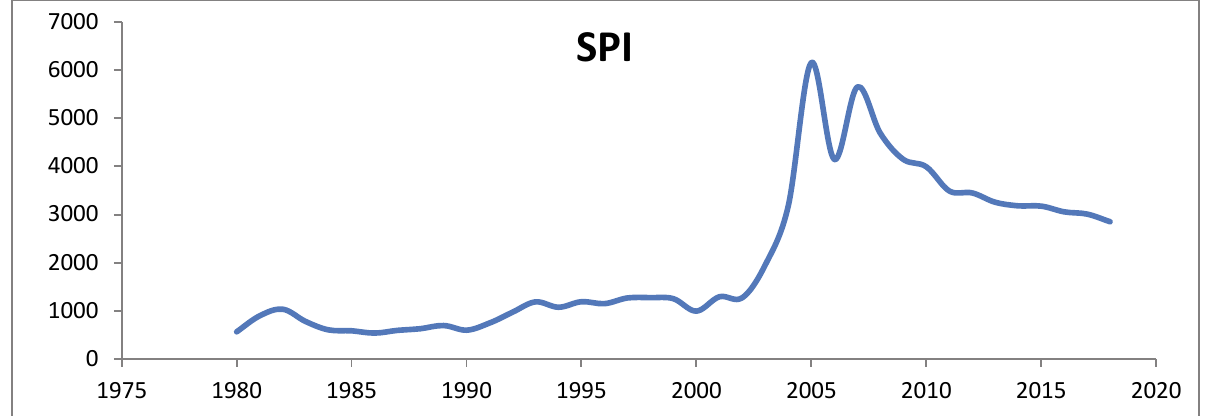
Fig. 1. The Development of the General Stock Price Index (SPI) in Amman Stock